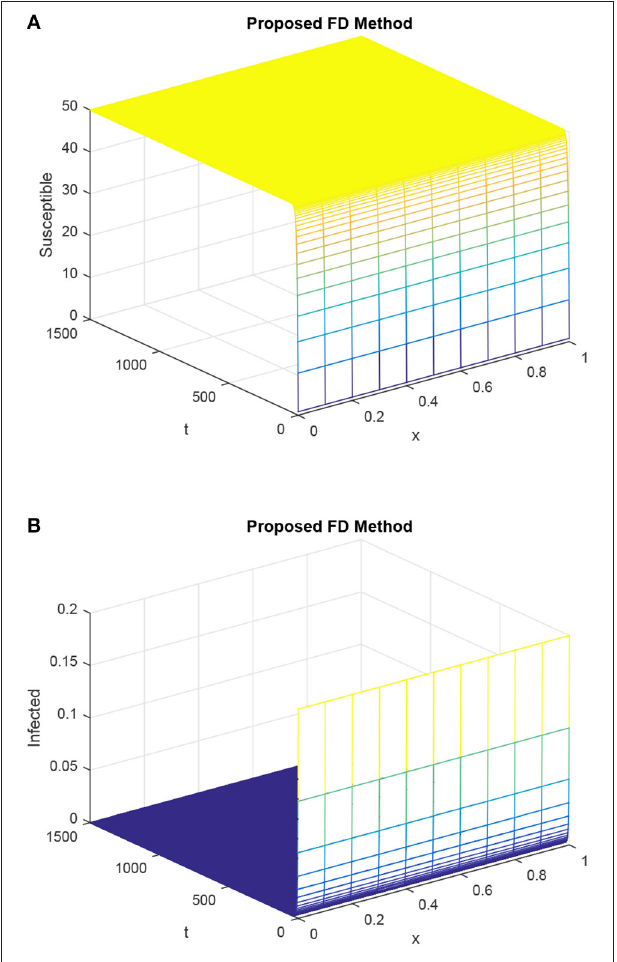
FIGURE 2 | Susceptible population and infected population dynamics by our proposed FD technique with the time step h = 0.1, R 1 , and R 2 kept equal and selected as 0.15, τ = 1.5. (A) Mesh graph of S . (B) Mesh graph of I